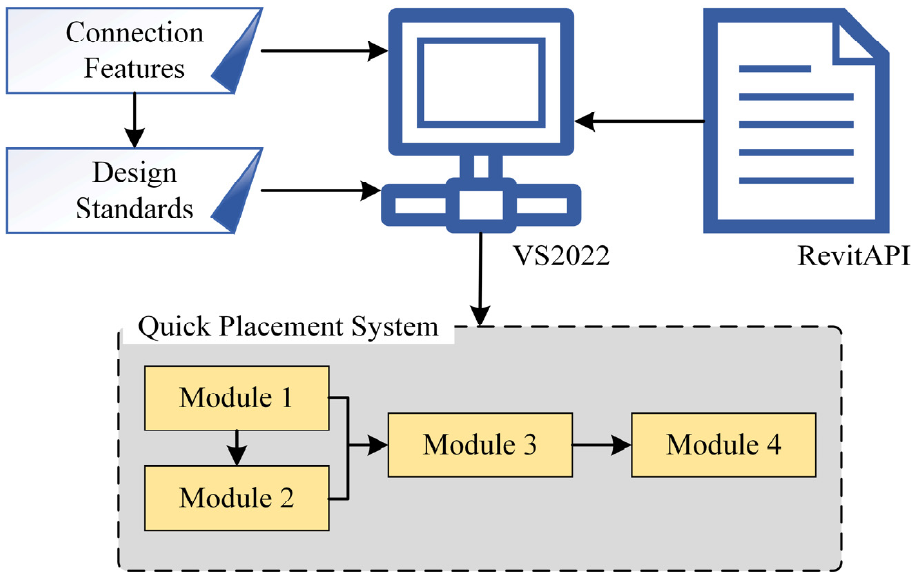
Figure 6. The framework of quick placement system.